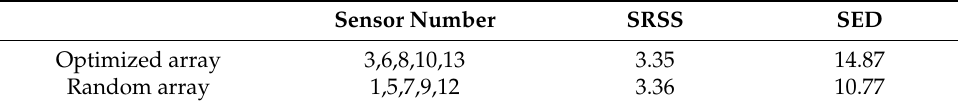
Figure 8. PCA map based on a randomly selected sensor array. Table 3. Sensitivity (SRSS) and selectivity (SED) of the optimized and random sensor